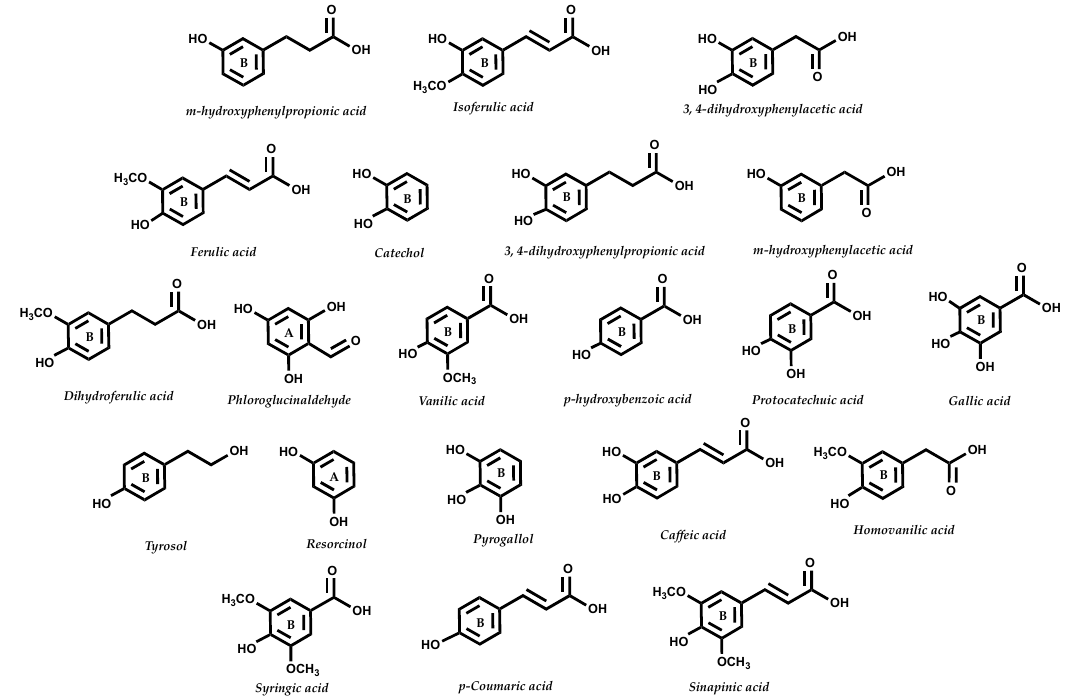
Figure 4. Main gut anthocyanin metabolites. Metabolites can be formed by enzymatic / microbiota action, and result from the breakdown of the C6-C3-C6 structure. Thus, metabolites can be either derived from ring A or B of the parent anthocyanin structure.